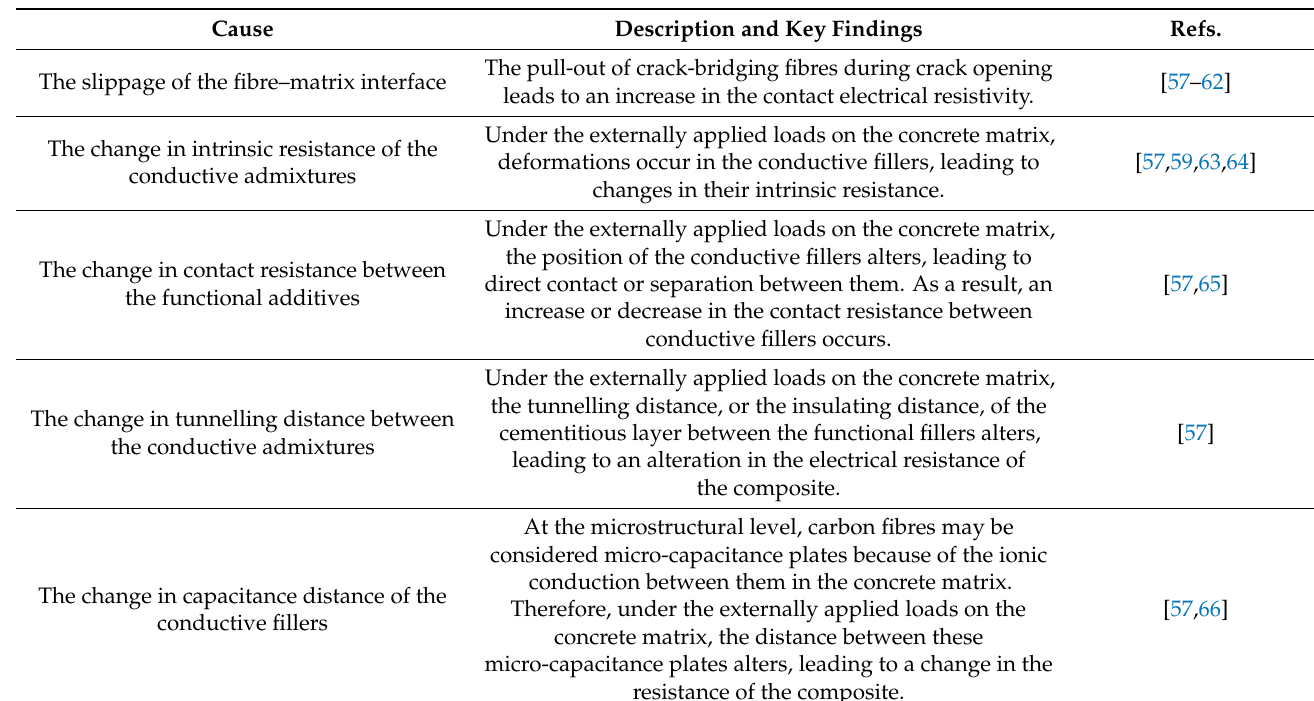
Table 2. Causes of piezoresistivity in cement-based